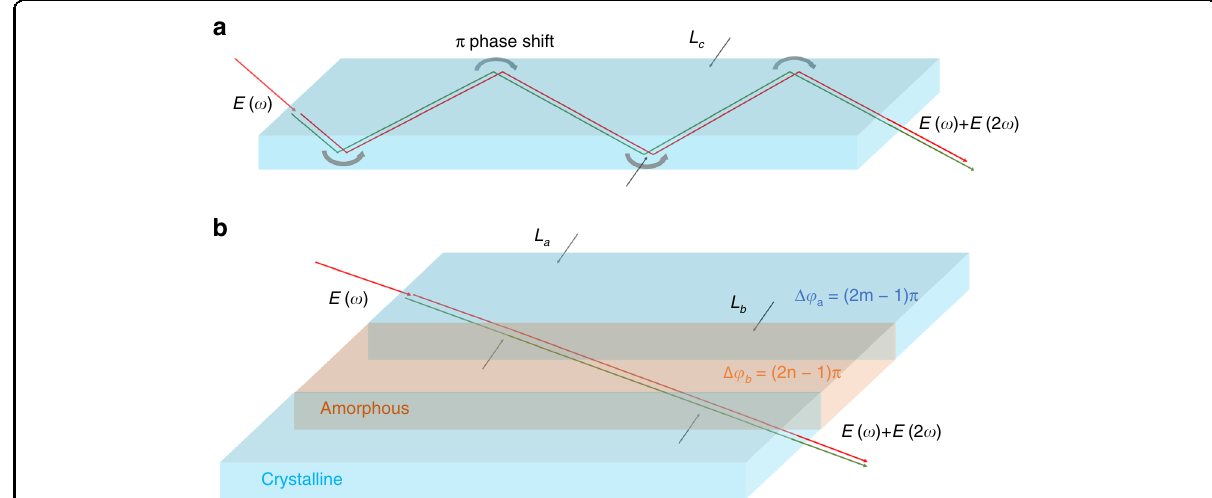
Fig. 1 Two different ways to provide phase manipulation if the phase is mismatched. a Schematic of the traditional method with a π phase shift at the interfaces. The interacting waves are totally re fl ected repeatedly with a propagation distance of L c ¼ π Δ E 2 ω ð Þ are inverted with a π phase shift at the interfaces. b Schematic of the APP with a continuous phase change. In crystalline regions, a nonlinear optical process occurs with a phase difference Δ φ a ¼ ð 2 m (cid:2) 1 Þ π , and then, in amorphous regions, phase manipulation operates with an APP Δ φ ¼ ð 2 n (cid:2) 1 Þ b